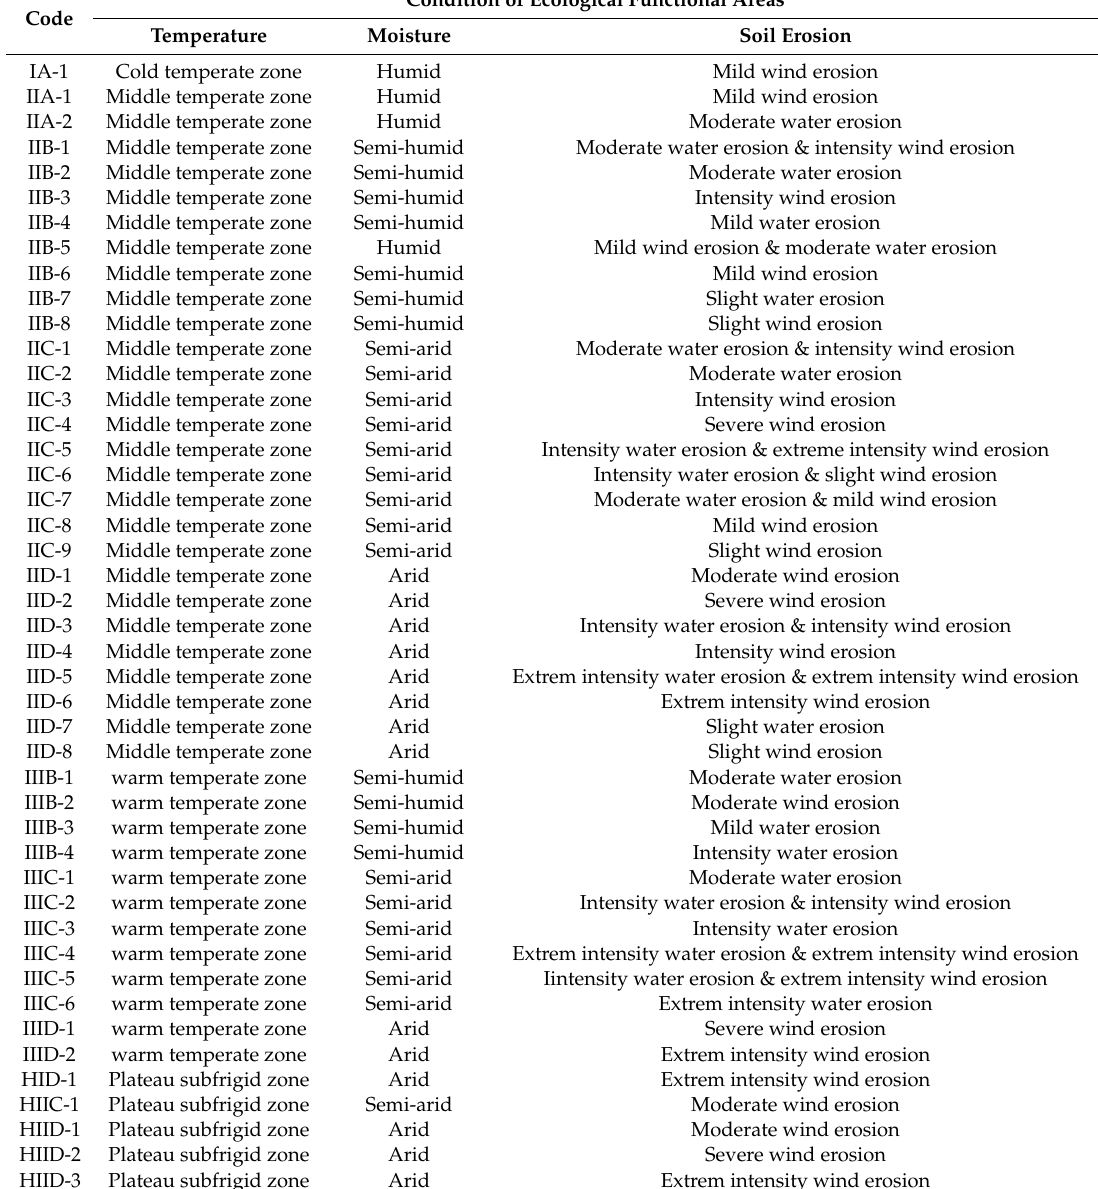
Table 2. Condition of 45 ecological functional